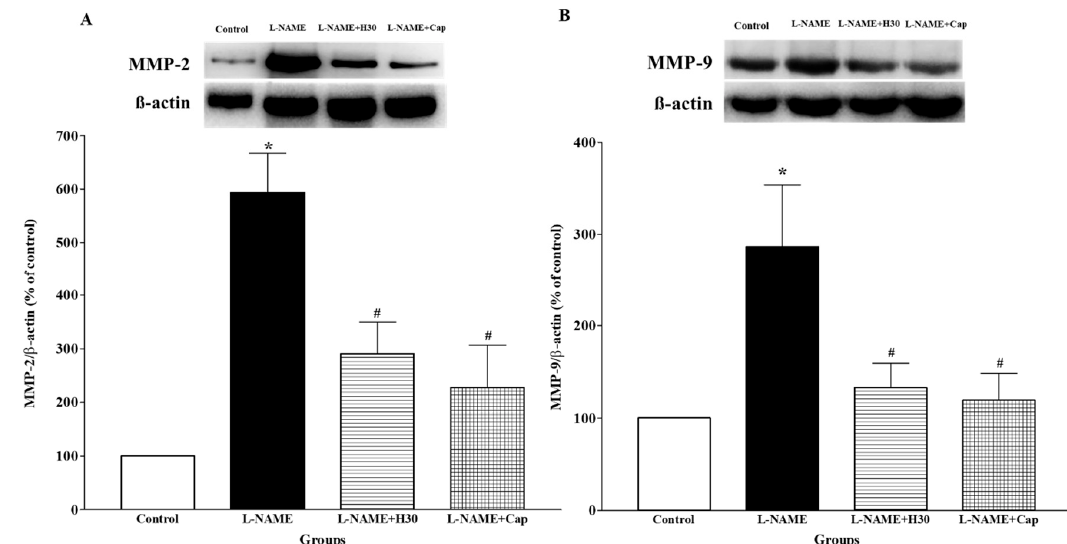
Figure 6. Effects of hesperidin and captopril on protein expression of MMP-2, ( A ) and MMP-9, ( B ) in aortic tissue collected from control, L -NAME, L -NAME + hesperidin (30 mg/kg) and L-NAME + captopril (2.5 mg/kg) groups. The top panels show the representative bands of MMP-2, ( A ) and MMP-9, ( B ) protein expression in thoracic aortas. Values are mean ± S.E.M ( n = 4 for each group), * p < 0.05 vs. control, # p < 0.05 vs. L -NAME